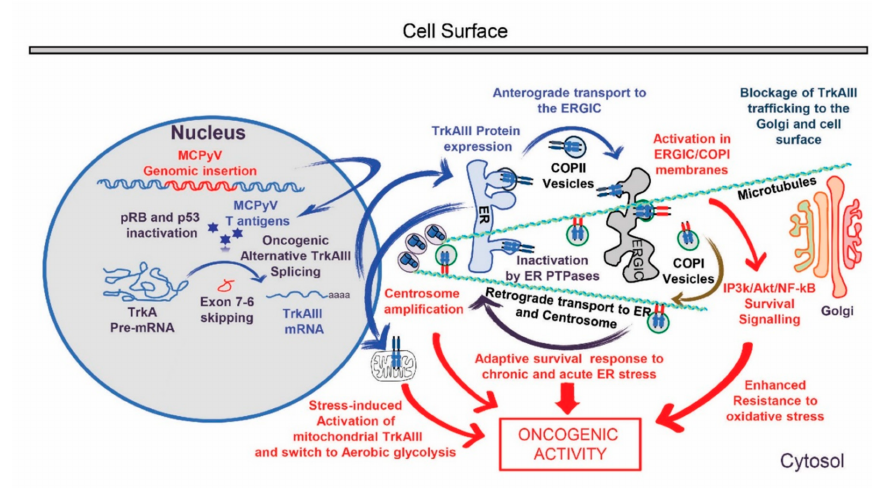
Figure 1. Schematic representation of genomic Merkel cell polyomavirus (MCPyV) insertion, T-antigen expression and induction of oncogenic alternative ∆ exon 6–7 TrkAIII splicing in Merkel cell carcinoma (MCC), leading to spontaneous intracellular ∆ exon 6–7 TrkAIII activation within endoplasmic reticulum intermediate and COP1 vesicle membrane compartments (ERGIC / COP1), inhibition of anterograde ∆ exon 6–7 TrkAIII transport, retrograde-activated ∆ exon 6–7 TrkAIII transport back to the endoplasmic reticulum (ER), centrosome and mitochondria, and oncogenic activity characterised by inositol-triphosphate 3-kinase (IP3K) / Akt survival signalling, centrosome amplification, an adaptive survival ER-stress response, enhanced resistance to oxidative stress and stress-induced aerobic